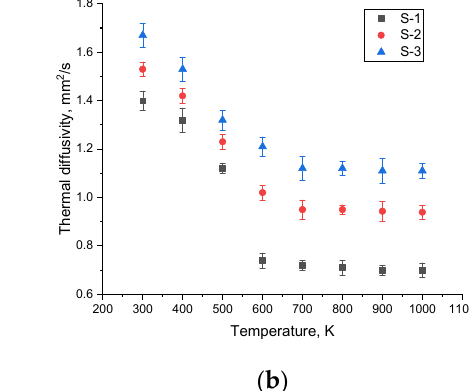
Figure 5. ( a ) Results of changes in thermal conductivity for the studied samples of ceramics; ( b ) results of changes in thermal diffusivity for the studied samples of ceramics.